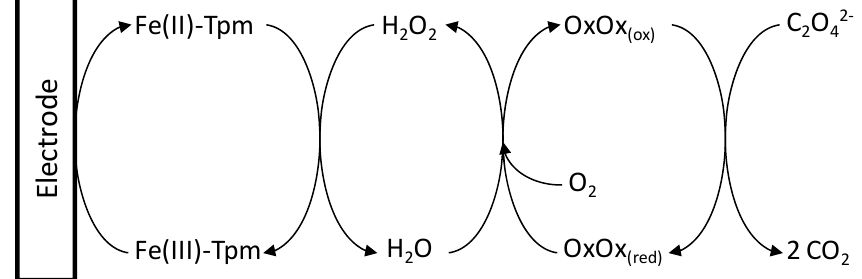
Figure 2. Reaction scheme for redox mediated oxalate